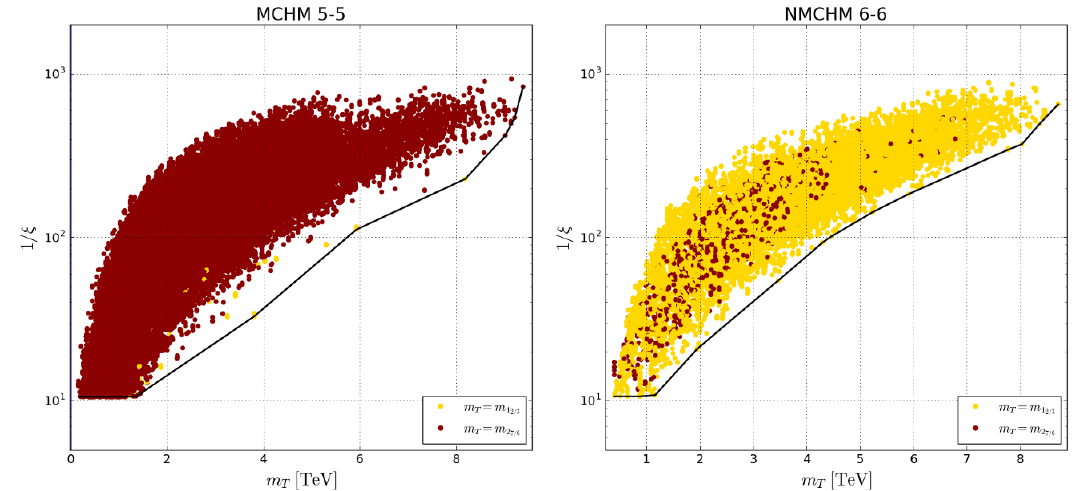
Figure 2. Comparison of each model’s lightest top partner vs. naive